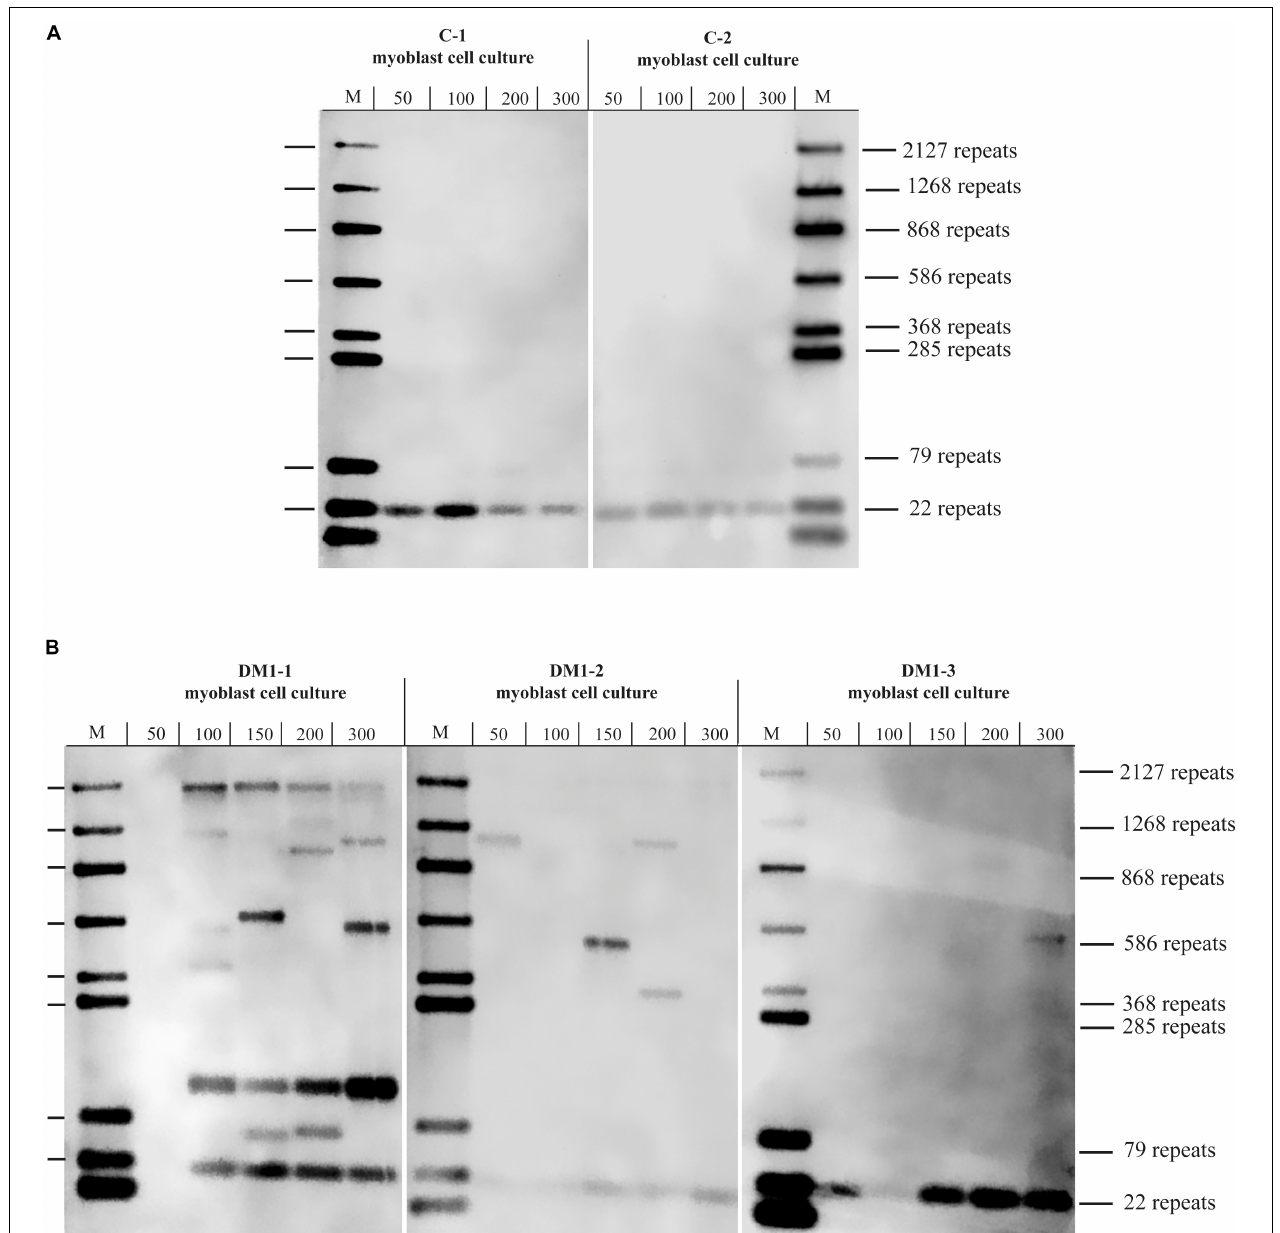
FIGURE 2 | Southern blot for (A) control and (B) DM1 primary myoblast cultures showing the different with the amount of used DNA in pg (as input for the small pool PCR) shown. M =